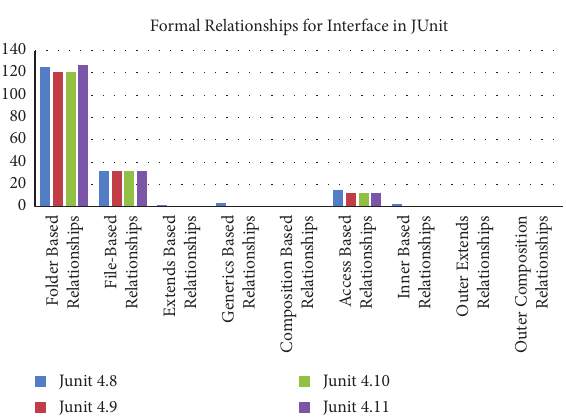
Figure 17: Count of formal relationships for interface in Junit.